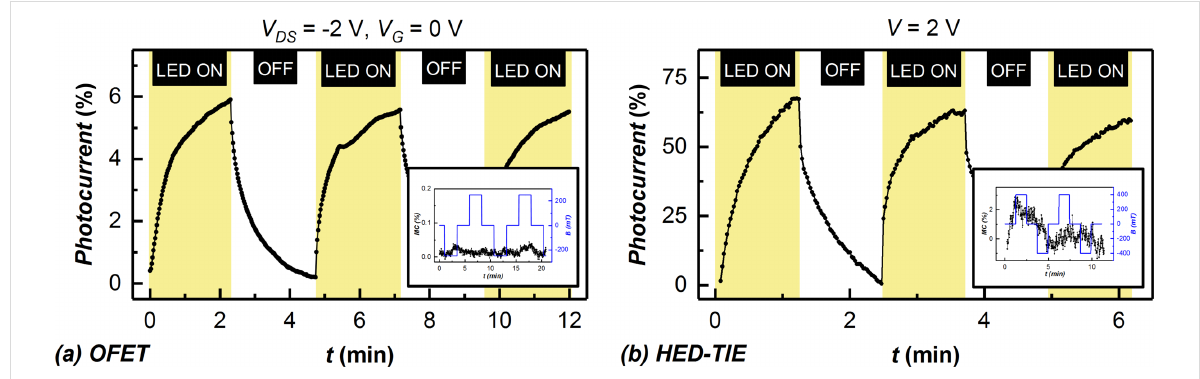
Figure 3: (a) Light switching of an OFET prepared by drop-coating of TIPS-pentacene diluted in water. The inset shows absence of the magnetoresis- tance in such an OFET. (b) Degraded light-switching behaviour of a TIPS-pentacene HED-TIE after two days of exposure to ambient atmosphere. The inset shows the response to applied magnetic